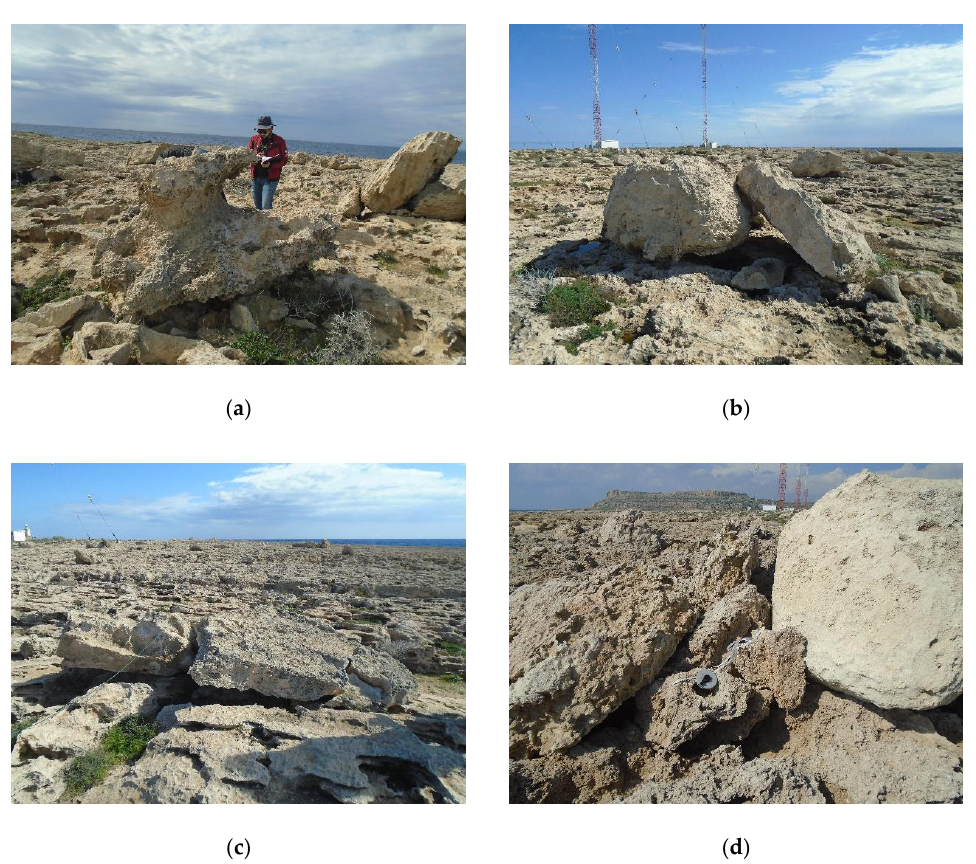
Figure 12. Boulder deposits on the western part of the study area most likely have a mixed origin; ( a ) boulder with likely origin from the cli ff edge; ( b ), ( c ) clusters of boulders; ( d ) a cluster of boulders of boulder with likely origin from the cliff edge; ( b ), ( c ) clusters of boulders; ( d ) a cluster of boulders of di ff erent sizes, the measuring tape provides the different sizes, the measuring tape provides the scale.